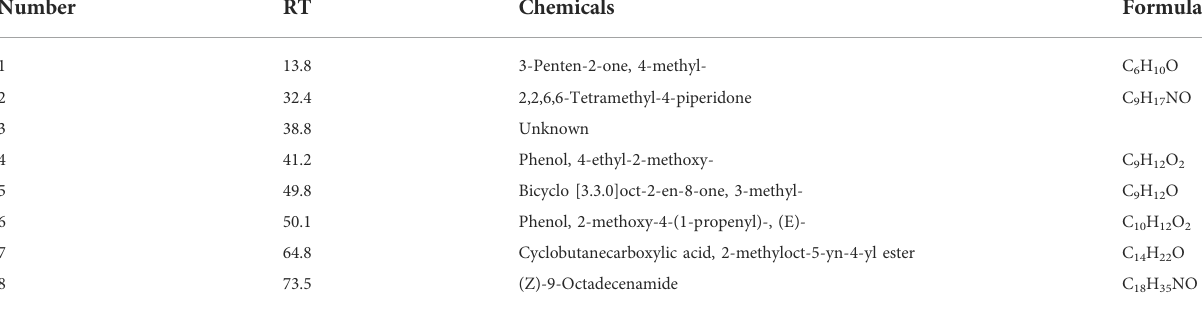
TABLE 7 The different components identi fi ed by GC-MS of the biocrude from continuous fl ow HTL of SS at 350 ° C with 8 min RT (retention time). Number